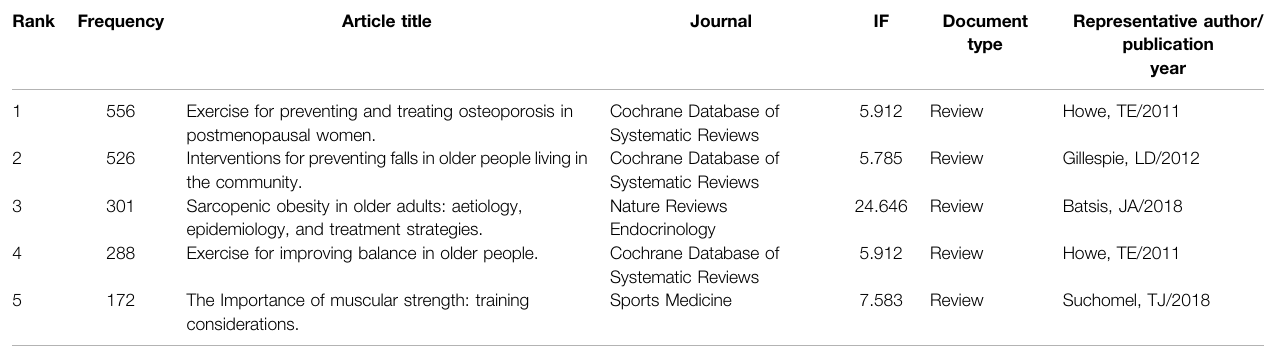
Frontiers in Bioengineering and Biotechnology |